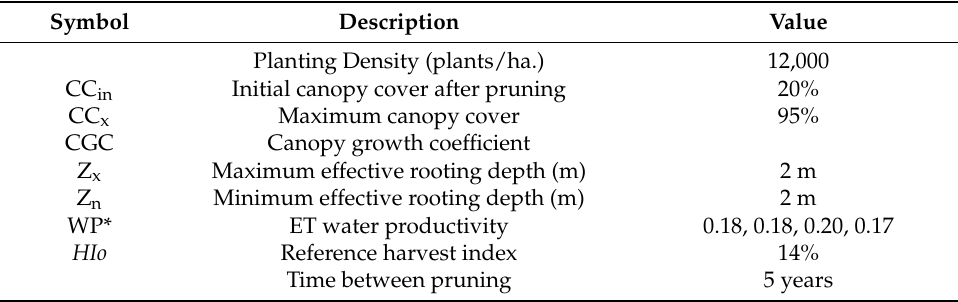
Table 4. Crop input data for